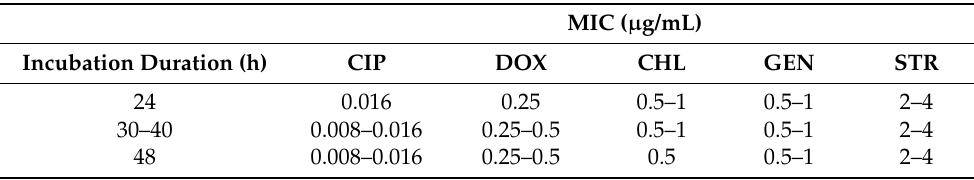
Table 13. Etest MIC values of F. tularensis at various time